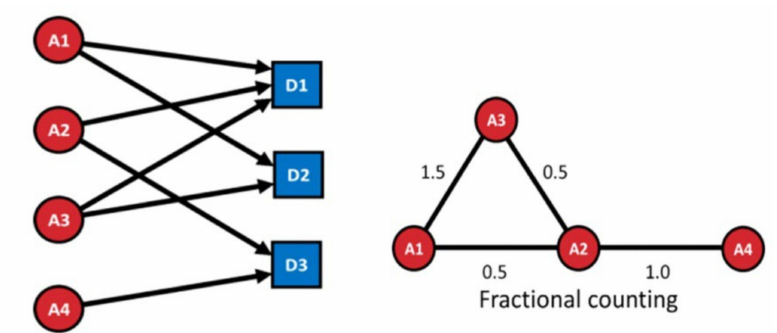
Figure 2. Scheme for the calculation of the strength of links between publications and authors based on the “fractional counting” function [Based on the VOSviewer